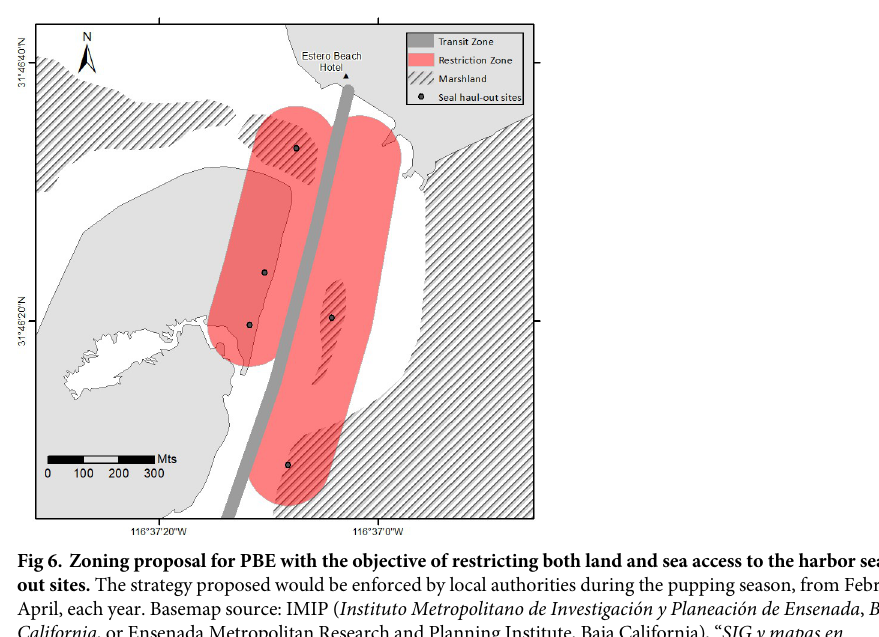
S1 Table. Posterior summaries for the proportion of high intensity reactions, by sampling year. SD = standard deviation.